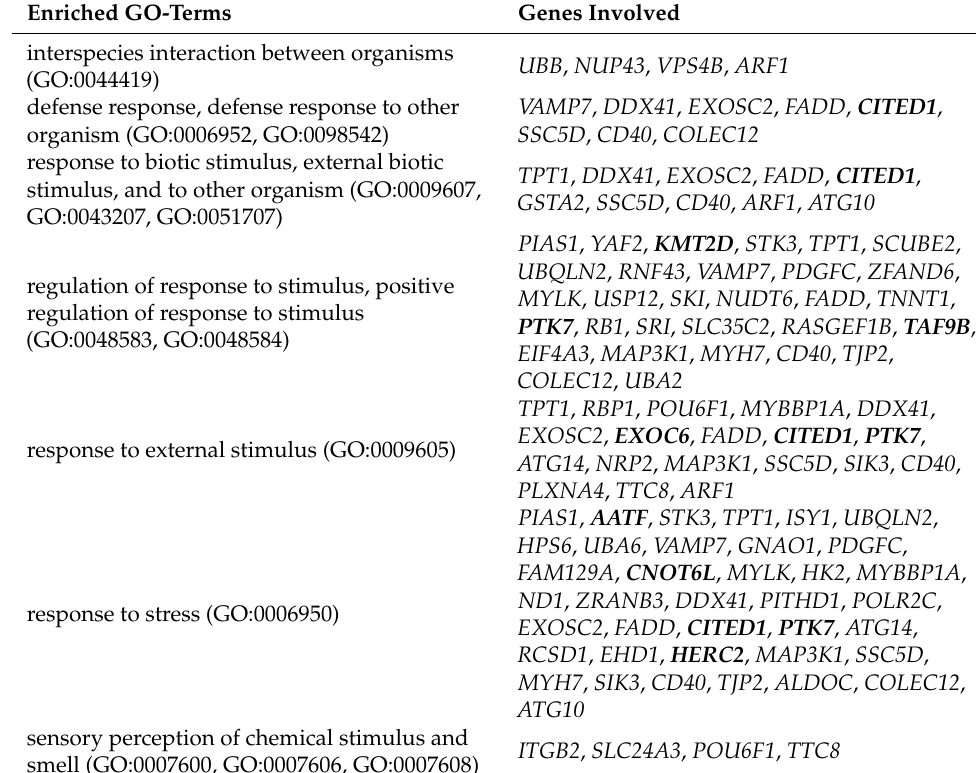
Table 1. The list of genes that could potentially be related to speciation processes found when com- paring L. gregalis and L. raddei .